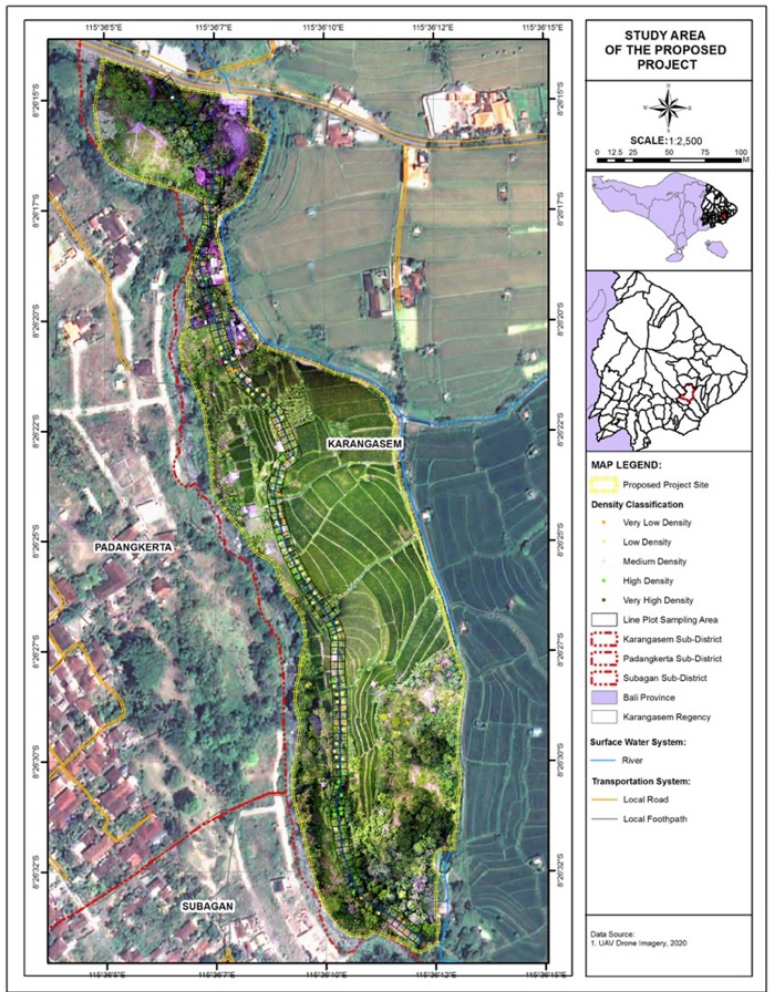
Figure 2 . Study area of the proposed